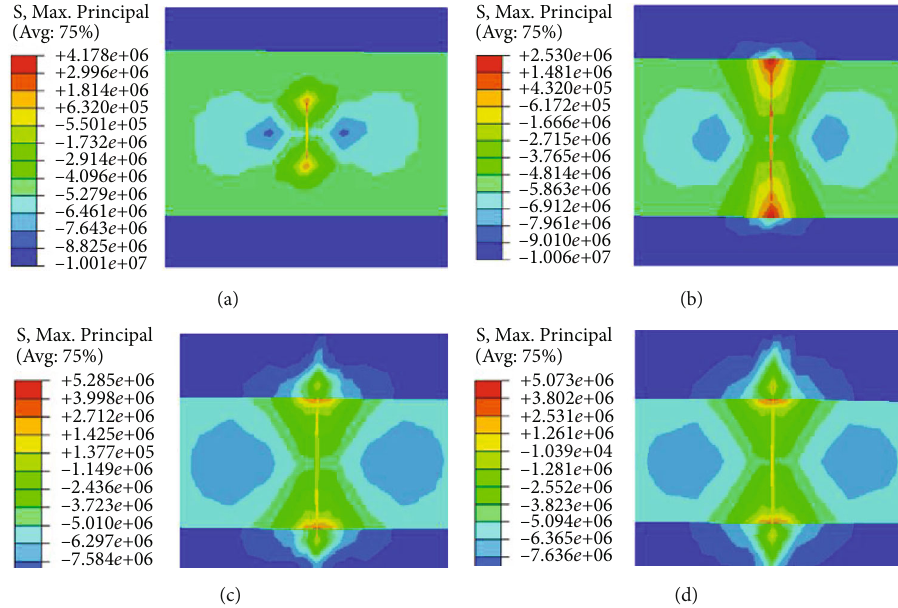
Figure 18: Hydraulic fracturing height for the base case at di ff erent times after the beginning of the fracturing process: (a) 10 steps, (b) 20 steps, (c) 40 steps, and (d) 50 steps.